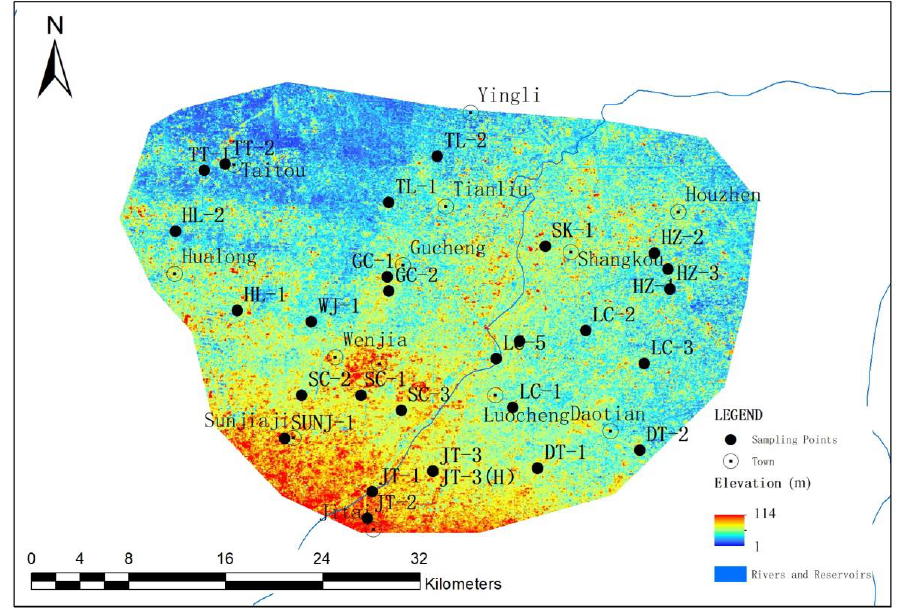
Figure 2. Distribution map of sampling points.